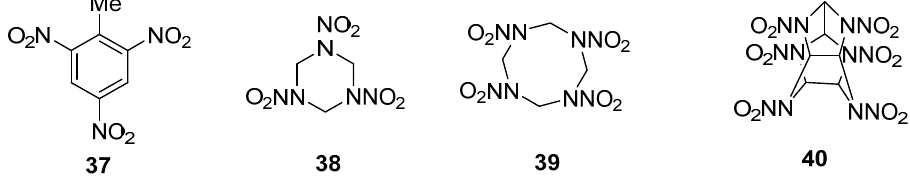
Figure 3. Examples of legacy secondary explosives TNT (37), RDX (38), HMX (39), and CL-20 (40). Royal Demolition Explosive (RDX, 1,3,5-trinitro-1,3,5-triazacyclohexane, 38), which